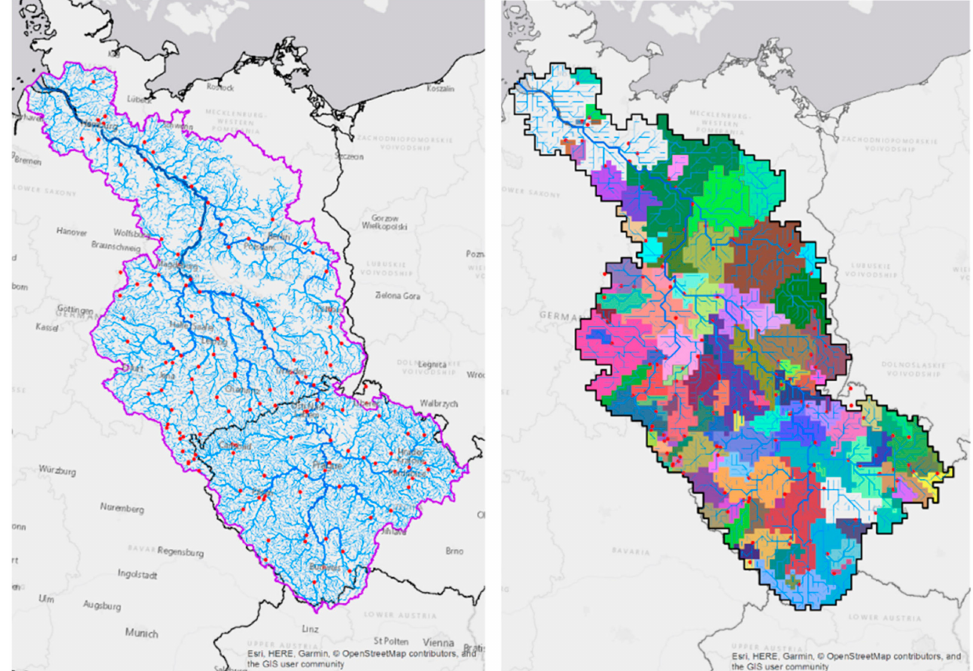
Figure 3. Example of the settings of the hydrological model for Elbe basin. Left —river network iden- tification, basin definition, collecting hydrological data for calibration; Right —model grid definition (consistent with climate model), river network schematization for discharge routing, definition of subbasements for calibration. Additional spatial datasets needed identified: field soil capacity, water capacity at wilting point, digital terrain model, flow direction raster, and soil